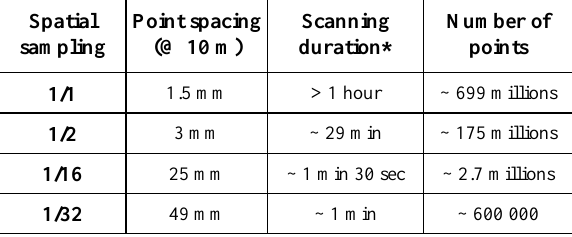
Table 3. Acquisition parameters for various samplings